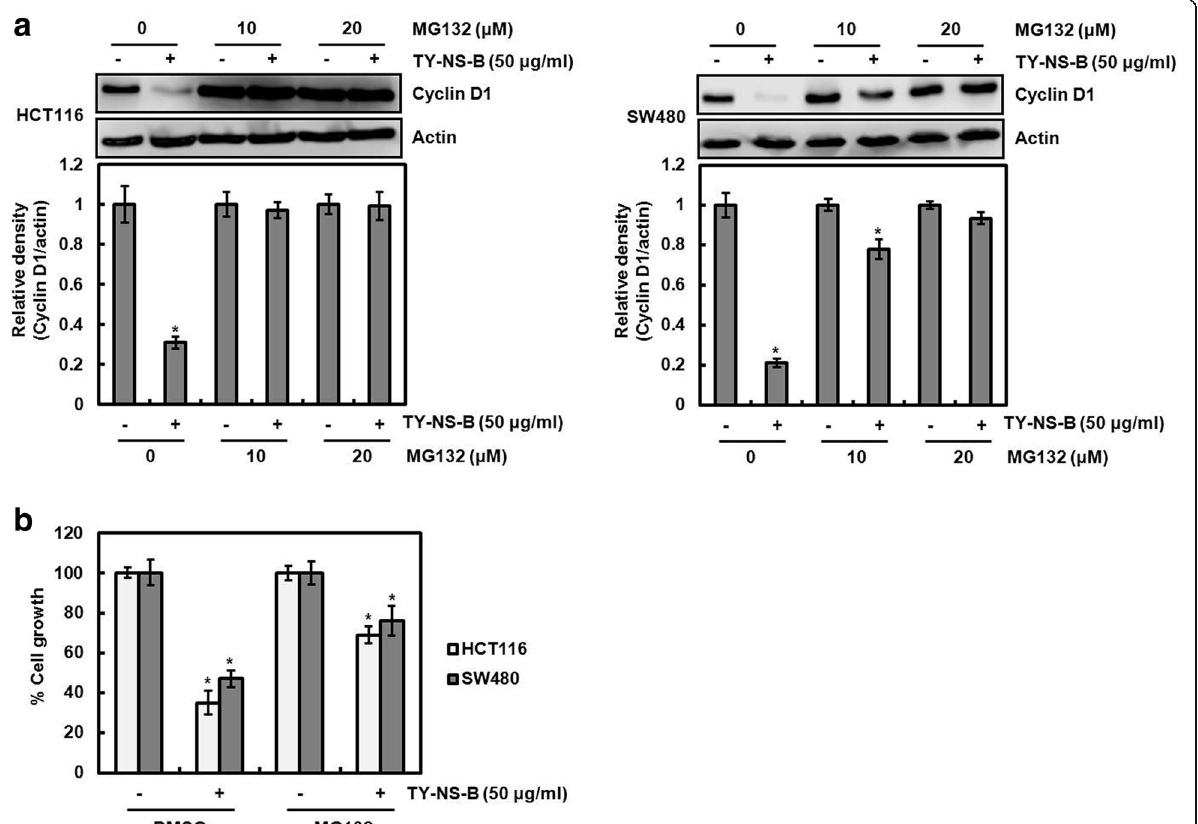
Fig. 4 The effect of TY-NS-B on cyclin D1 degradation. a HCT116 and SW480 cells were pretreated with MG132 (10 and 20 μ M) and then co-treated with TY-NS-B (50 μ g/ml). Cell lysates were subjected to SDS-PAGE and the Western blot was performed using antibody against cyclin D1. Actin was used as internal control for Western blot analysis. Relative density for Western blot was measured using the software Un-SCAN-IT gel Version 5.1 (Silk Scientific, Inc). Data represent mean±SD for three independent experiments. * P <0.05 compared to cell without TY-NS-B. b HCT116 and SW480 cells were pretreated with MG132 (20 μ M) and then co-treated with TY-NS-B (50 μ g/ml) for 24 h. Cell growth was measured using MTT assay. Data represent mean±SD for three independent experiments. * P <0.05 compared to cell without